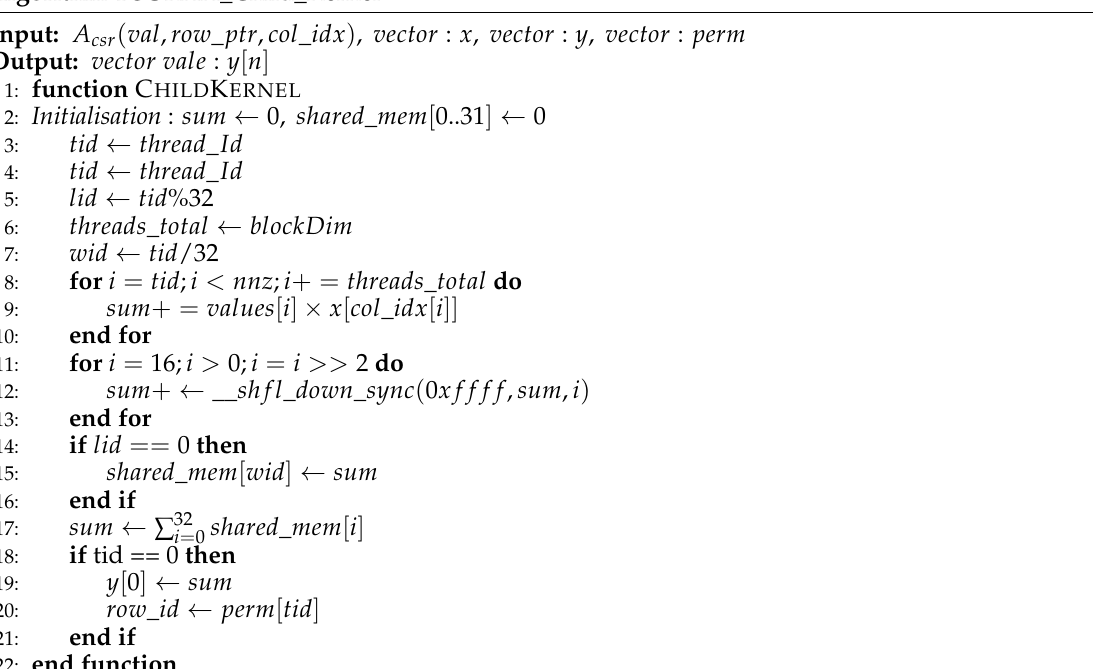
Algorithm 4 SURAA_Child_Kernel